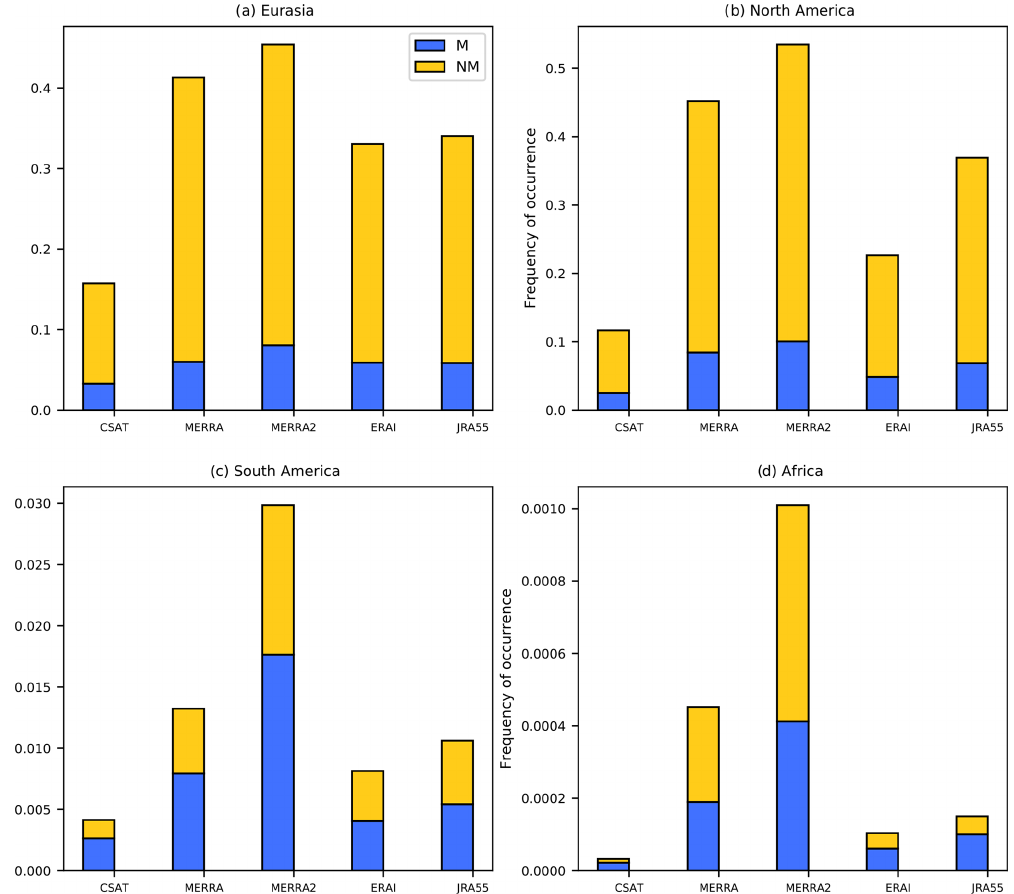
Figure 5. Frequency of occurrence of snowfall estimates over (a) Eurasia, (b) North America, (c ) South America and (d) Africa for CloudSat, MERRA, MERRA-2, ERA-Interim and JRA-55 over the time period 2007–2016. Mountain snow is in blue and non-mountain snow is in